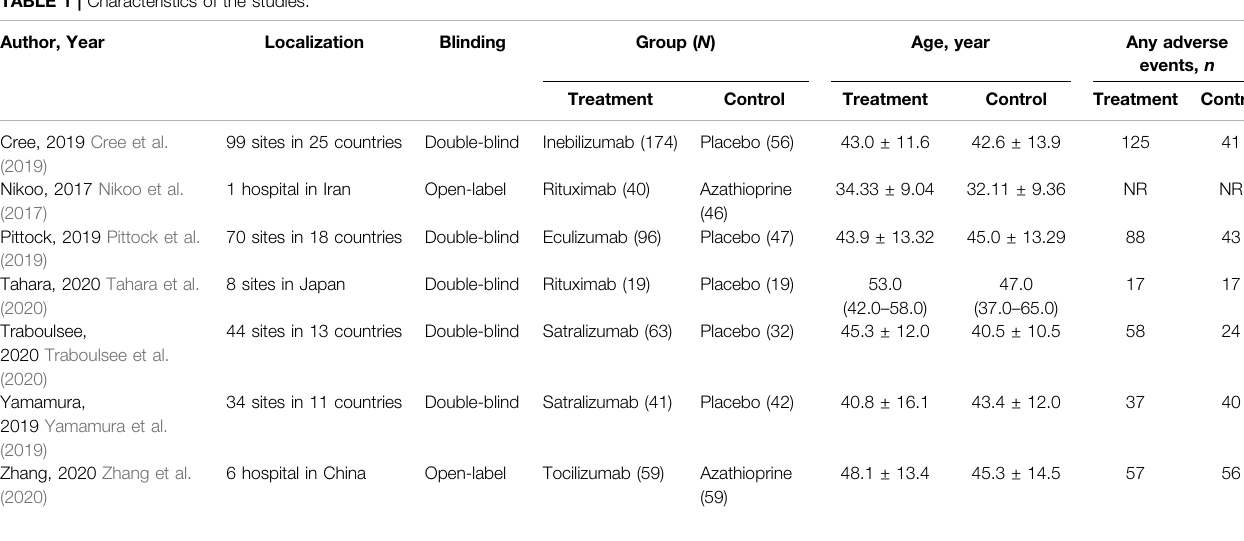
TABLE 1 | Characteristics of the